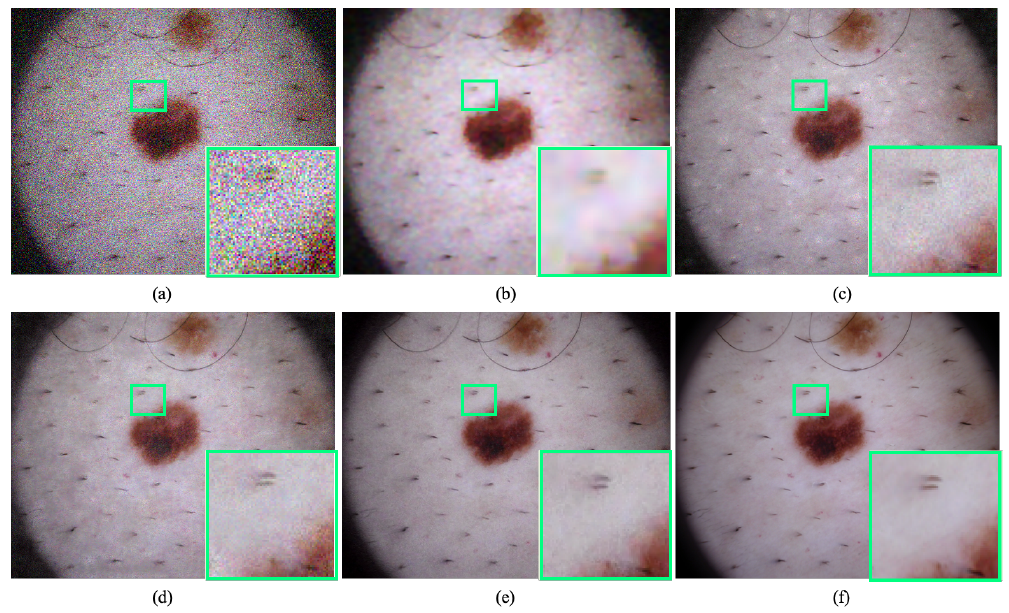
Figure 7. Qualitative comparison of dermatology image denoising at σ = 50. The proposed method illustrates significant improvement over the existing denoising method by improving perceptual image quality. ( a ) Noisy input. ( b ) Result obtained by BM3D [11]. ( c ) Result obtained by DnCNN [16]. ( d ) Result obtained by Residual MID [12]. ( e ) Result obtained by DRAN (proposed). ( f )